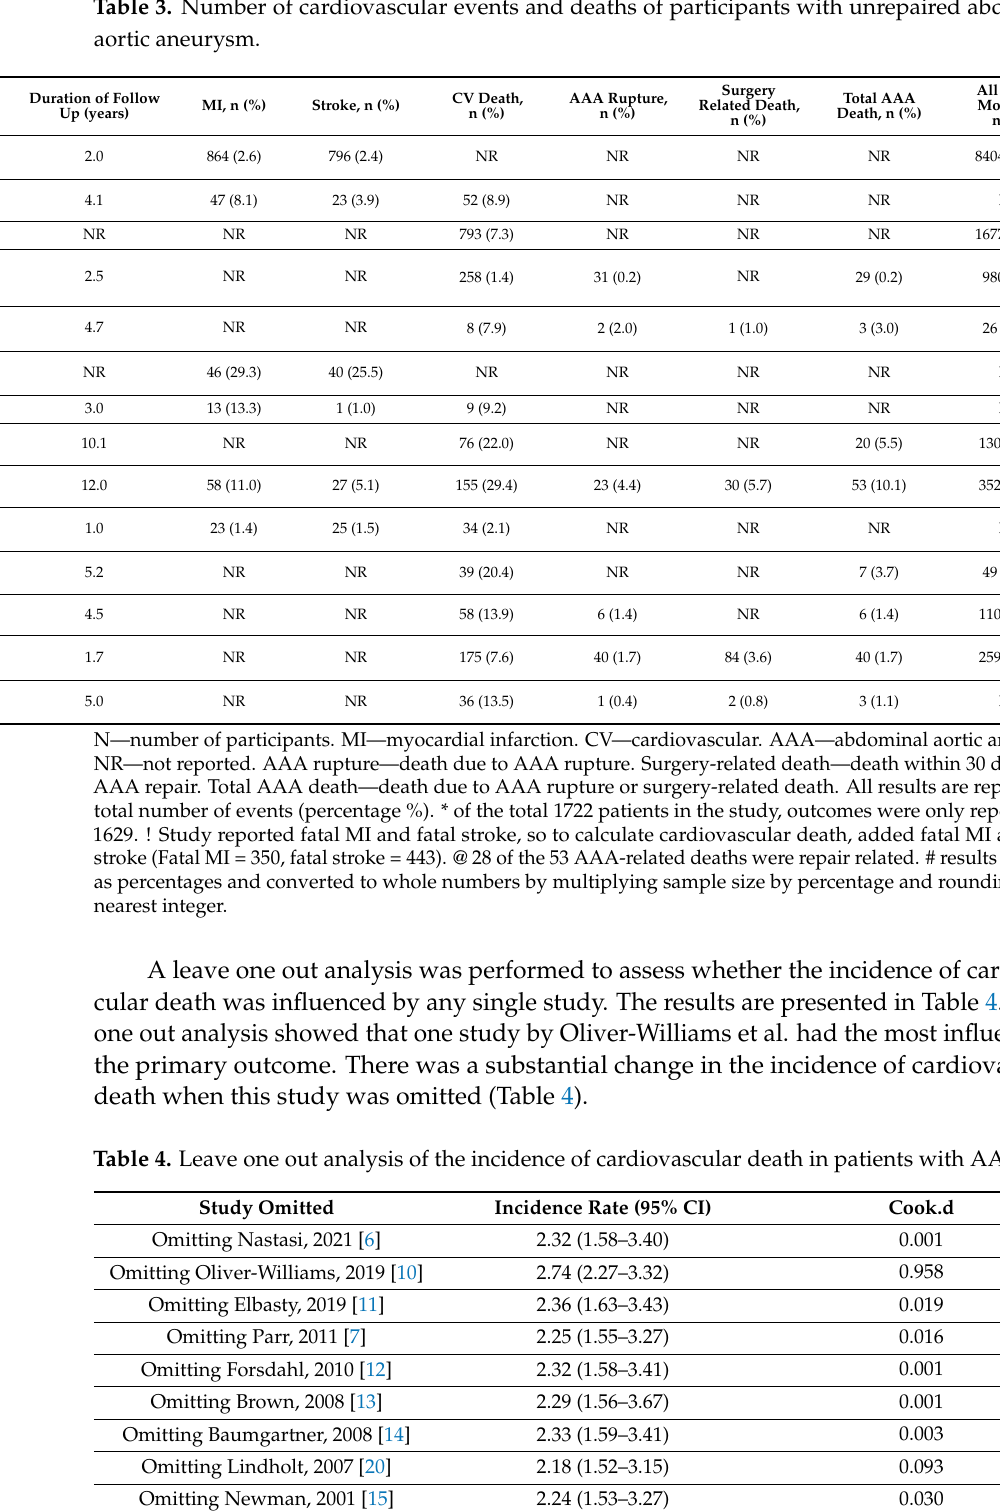
dataset, a value greater than 0.50 was considered